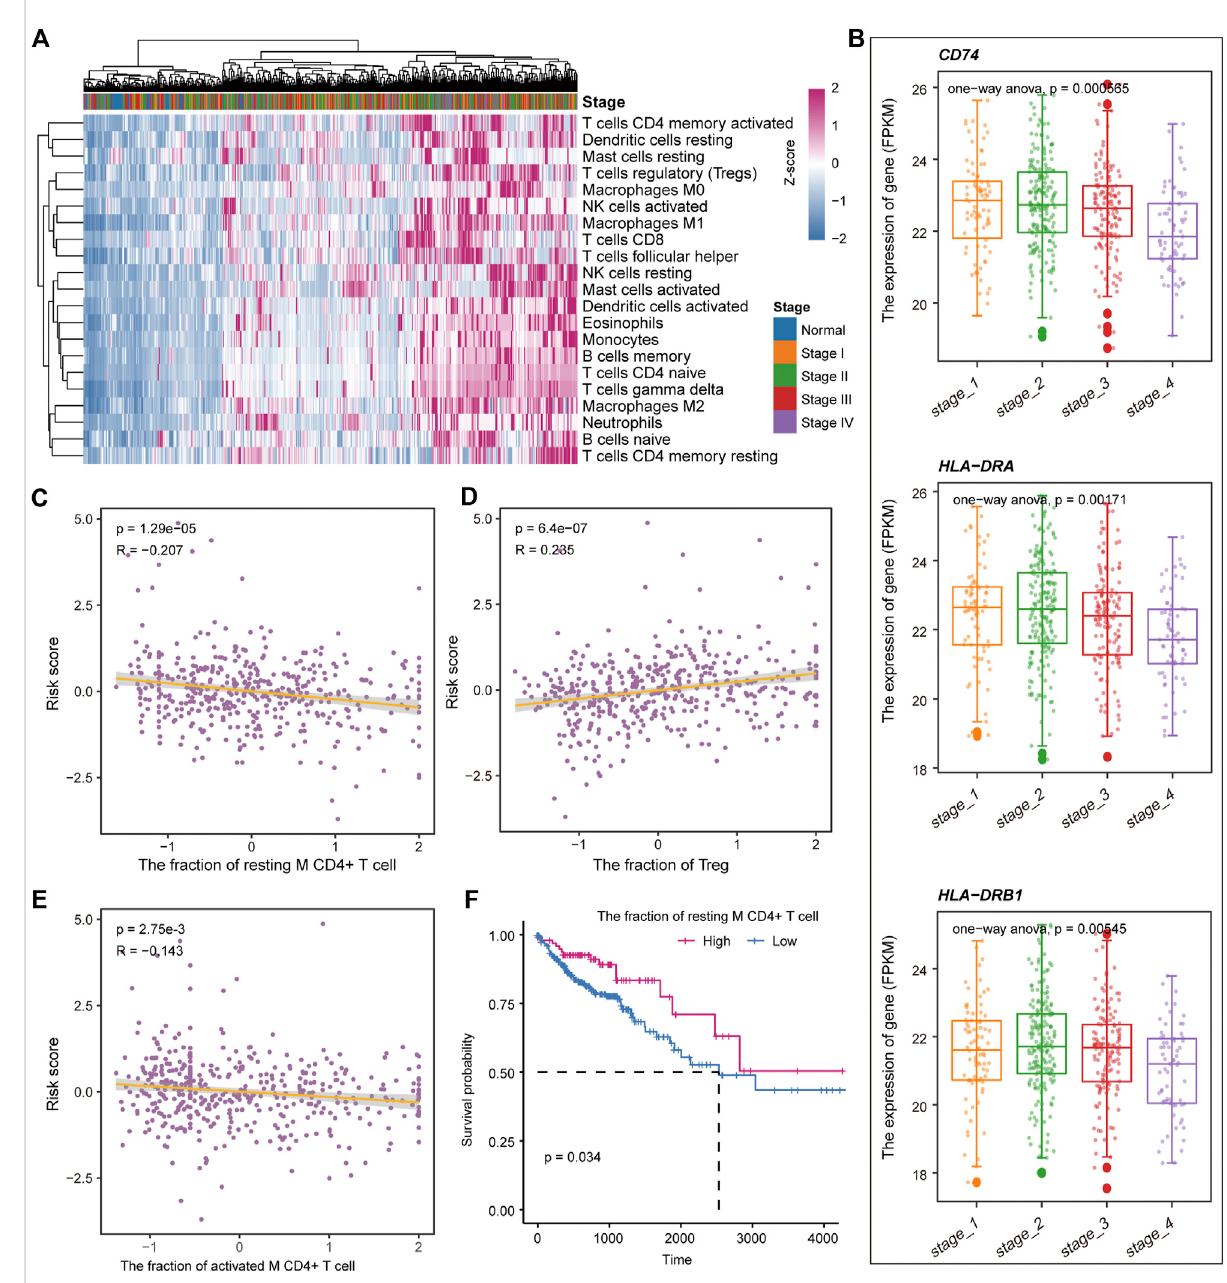
FIGURE 7 Immune cell components relate to the patient ’ s survival risk. (A) The immune cell composition of each sample is displayed by heat map. The column label represents the clinical stage of the sample. (B) The expression levels of genes encoding MHC II molecules in each clinical stage are shown by boxplot. ANOVA is used to calculate statistical signi fi cance. (C – E) The correlation between the risk score and the fraction of the resting CD4 + T cell, activated M CD4 + T cell, and Treg. (F) Kaplan-Meier curves for survival in high/low-fraction groups of the resting CD4 + T cell. Log- rank test was used to calculate statistical signi fi